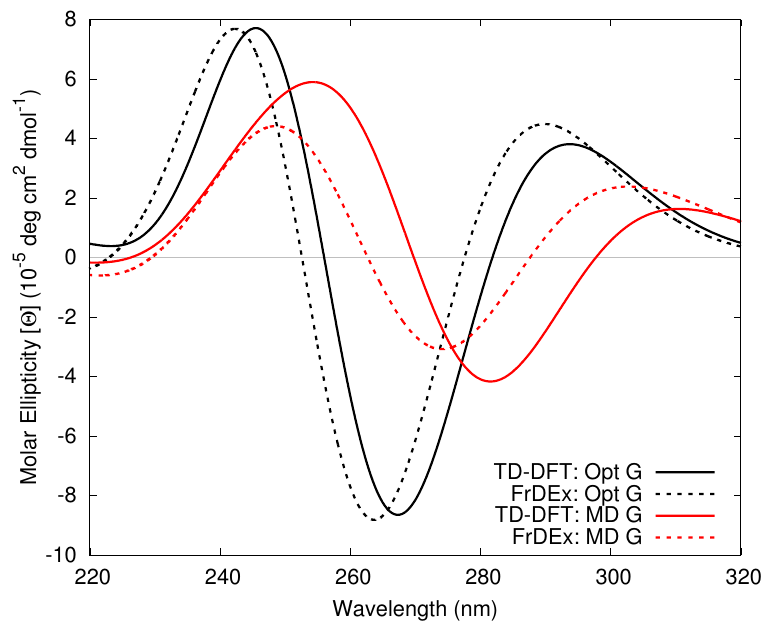
Figure 3. Computed ECD spectra of Tel21 GQ at 100 ns using as a geometry for G either the optimized structure of G monomer (black) or the geometry directly extracted from MD simulations (red). FrDEx spectra are reported as dashed lines and the full QM spectra as solid lines. All FrDEx calculations use pairs as the SC to calculate H inter and strands for H intra . All spectra shifted by − 0.85